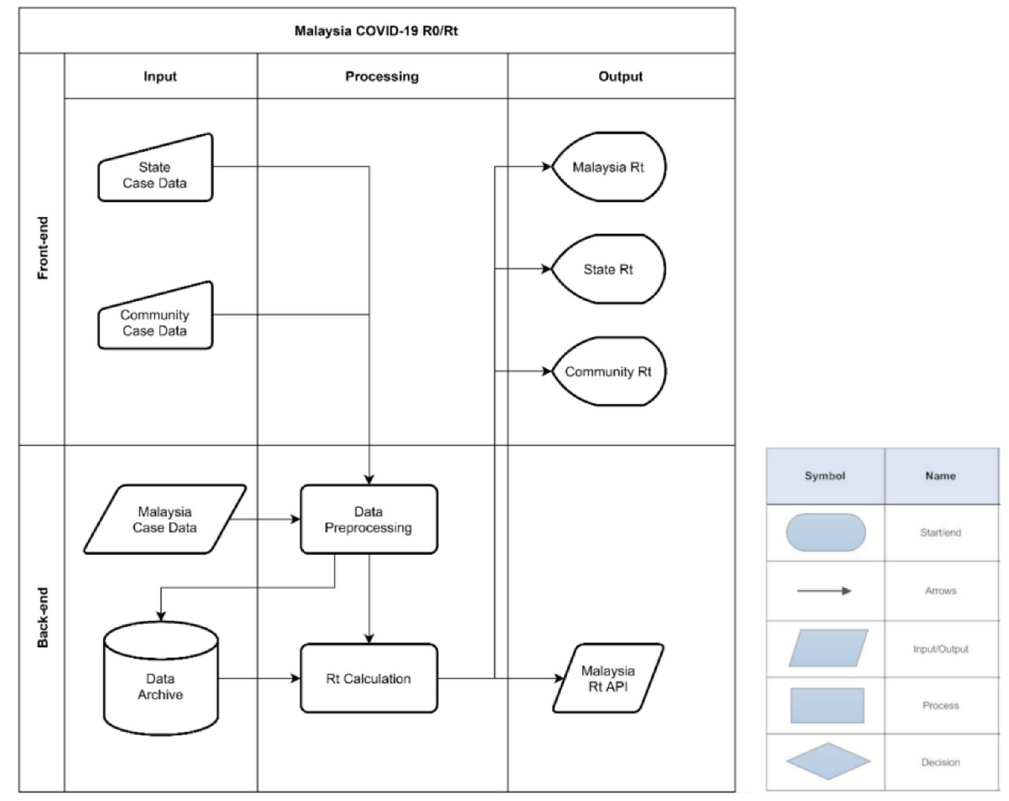
Figure 1. HYPERLINK "sps:id::fig1||locator::gr1||MediaObject::0" Automated web application system flow